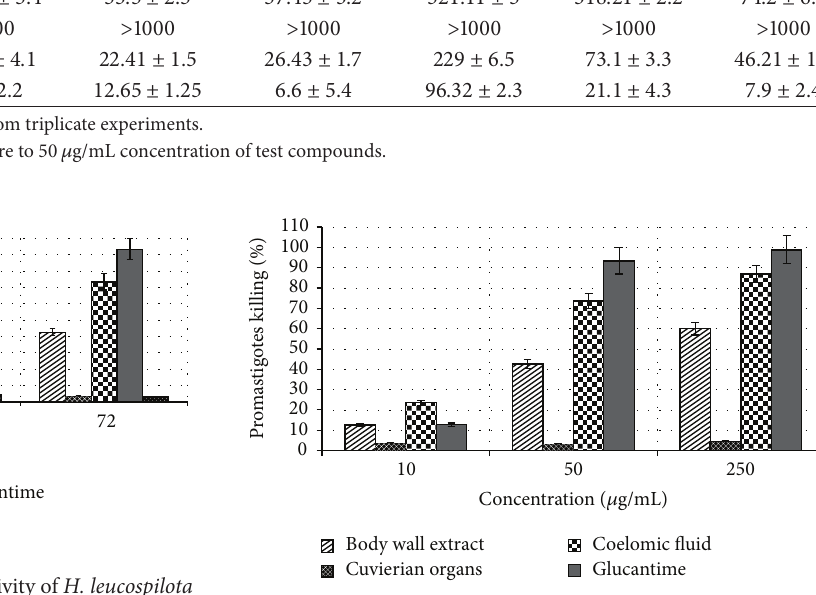
Figure 2: Concentration-dependent leishmanicidal activity of H. leucospilota extracts against L. infantum promastigotes. The results are shown as a percentage of parasite killing from three independent experiments performed as triplicate (mean ± SE) using MTT assay after 72 hours of exposure.